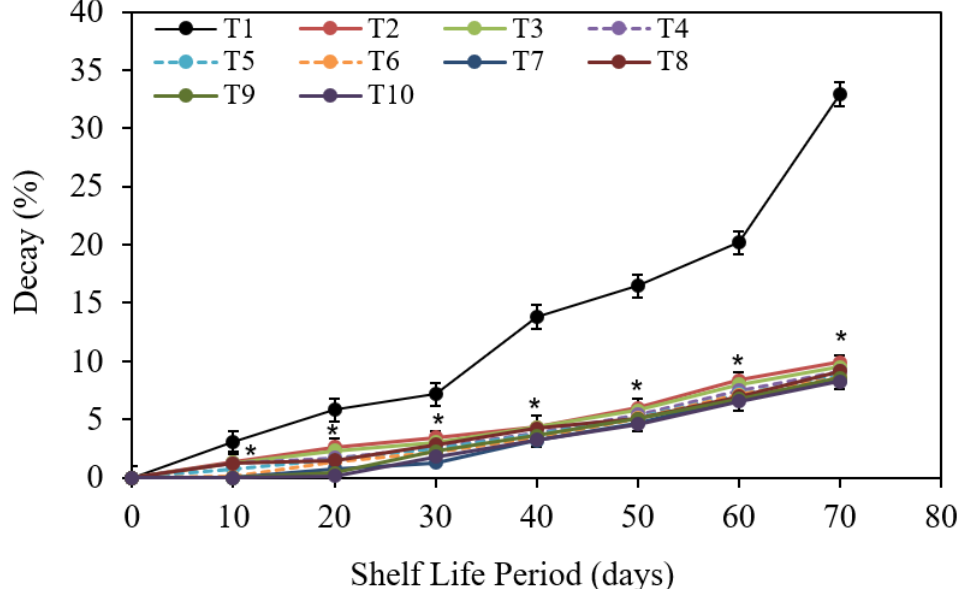
Figure 5. The impact of pre-harvest chitosan, chitosan nanoparticle and CaCl 2 foliar spray treatments on decay percentage of Barhi date fruits under cold storing for 70 d. Note that * sign denotes the significant differences between the control and edible coatings treatments, and T1, T2, T3, T4, T5, T6, T7, T8, T9, and T10 are water (control), 1 g/L chitosan, 2 g/L chitosan, 3 g/L chitosan, 1 g/L